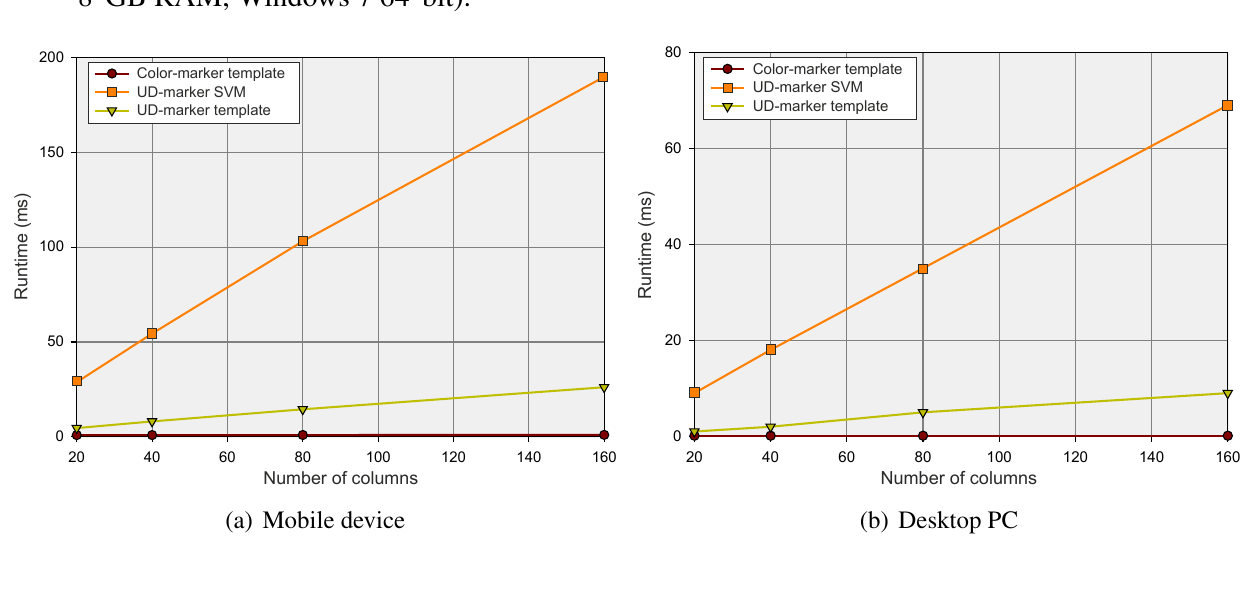
Figure 24. Runtimes for different marker detection methods on ( a ) a mobile device (Intel i5M 2.53 GHz, 4 GB RAM, Windows 7 64 bit) and ( b ) an desktop PC (Intel i5 2.80 GHz, 8 GB RAM, Windows 7 64